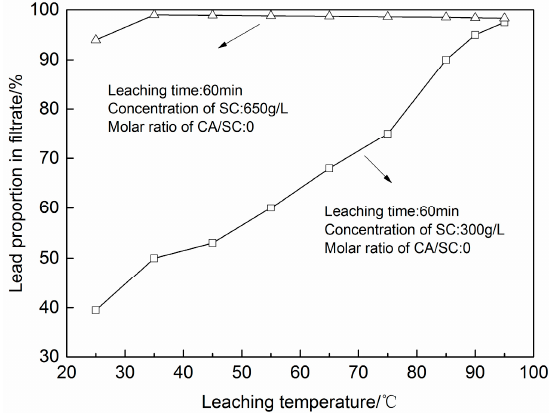
Figure 2. Lead proportion in filtrate with different leaching temperatures (leaching time is 60 min, concentration of SC is 650 g/L or 300 g/L, molar ratio of CA/SC is 0).